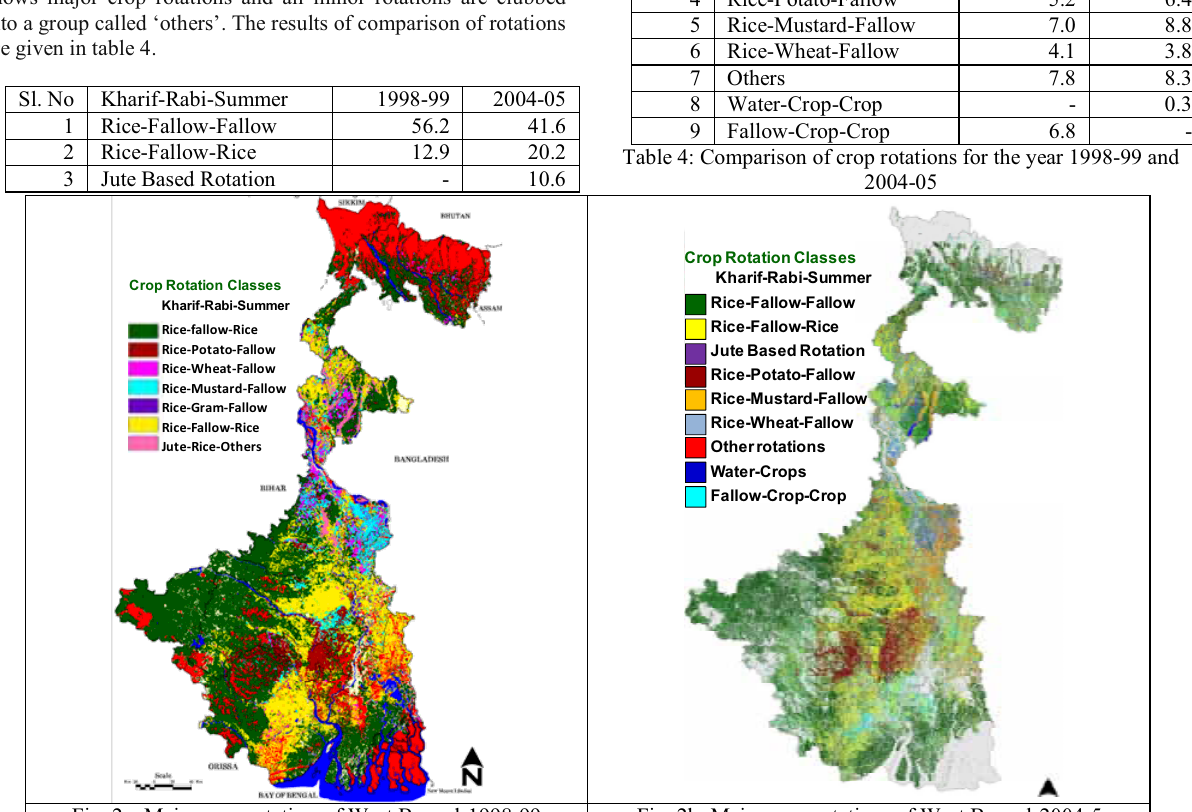
Table 4: Comparison of crop rotations for the year 1998-99 and